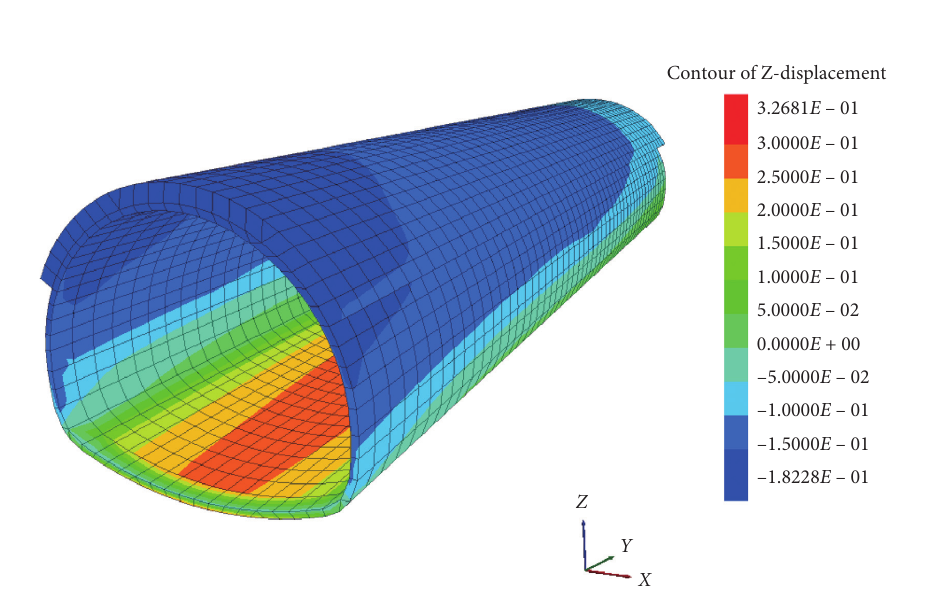
Figure 10: Deformation of the tunnel structure under the original